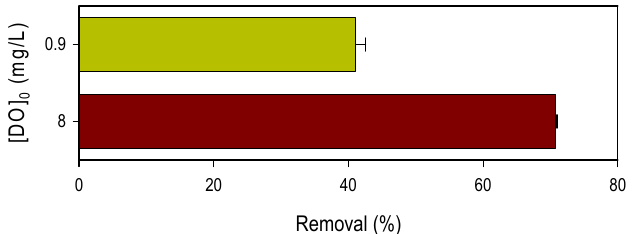
Figure 5. Influence of the concentration of DO on CBZ degradation by the Mn(III)/HSO 3 − process. [CBZ] 0 = 5 µM, [Mn(III)] 0 = 50 µM, [HSO 3 − ] 0 = 250 µM, [PP] = 2.5 mM, pH = 7.0.